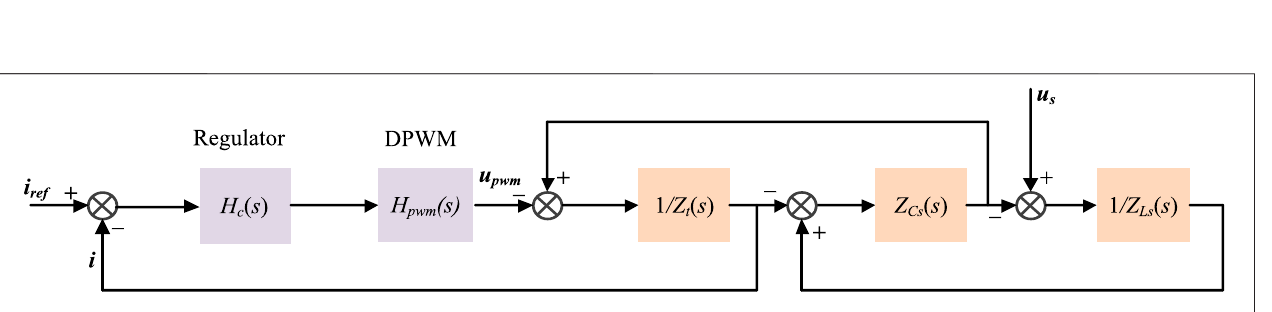
Frontiers in Energy Research |